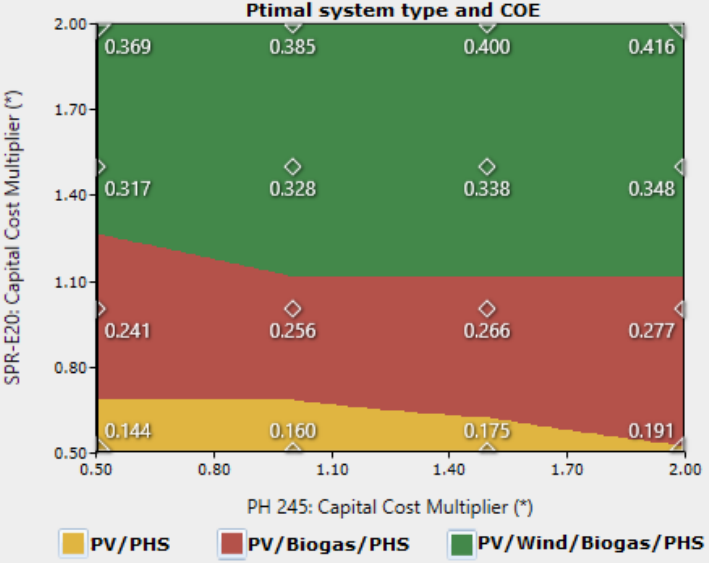
Figure 20. Sensitivity analysis result of the price and availability of biomass. The result of the sensitivity analysis of maximum capacity shortage is illustrated in Figure 21. It shows that an improvement of the reliability of the system by lowering the maximum annual capacity shortage from 5% to 2.5% would result in NPC and COE increases of only 0.6% and 0.4%, respectively, while an improvement to 0% would result in increases of 9% and 7%, respectively. On